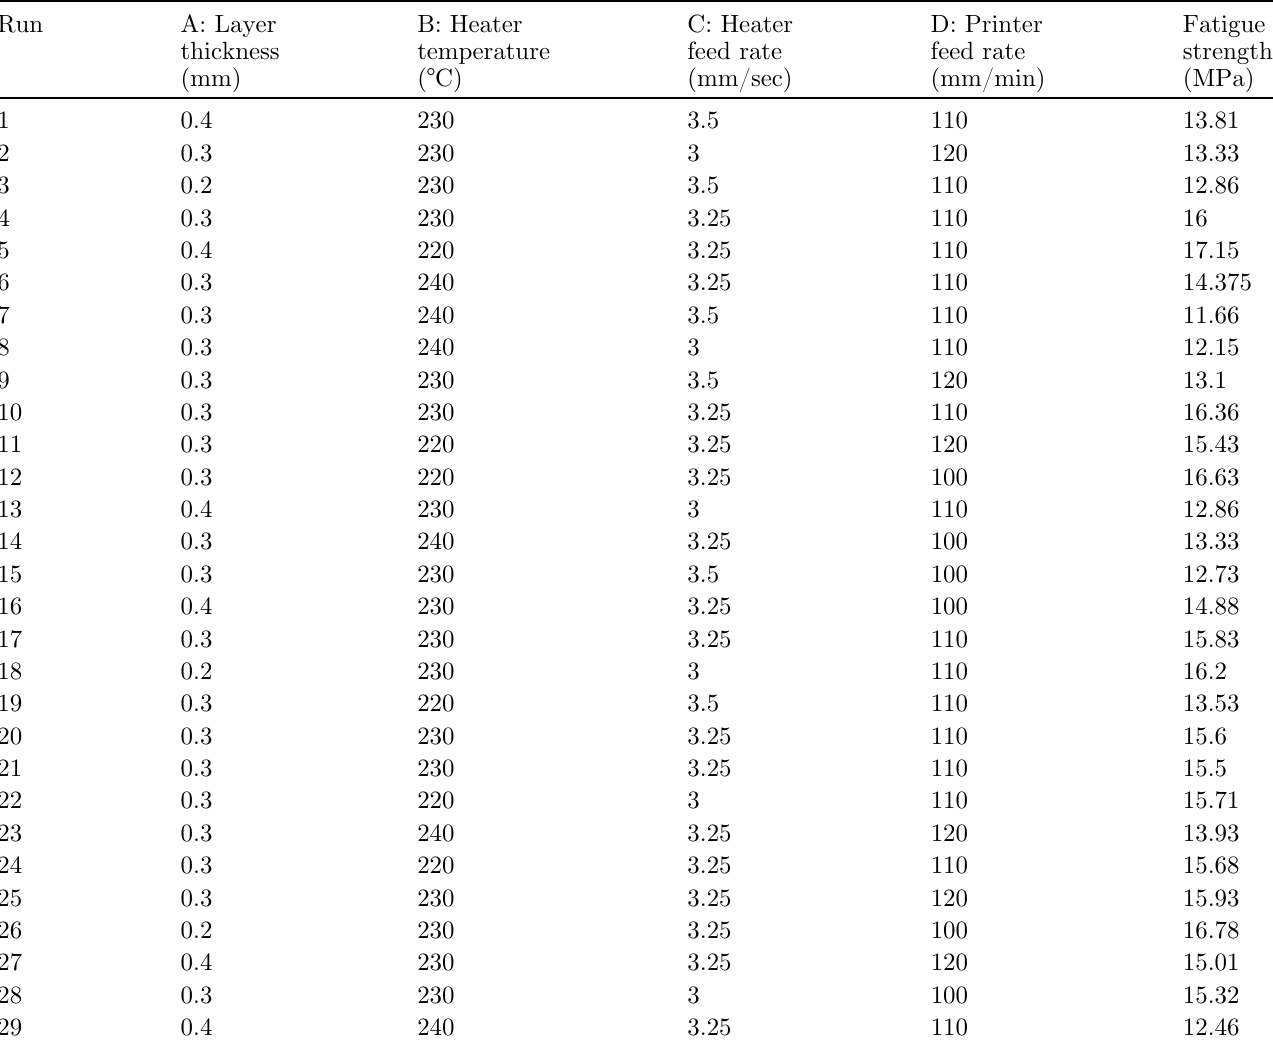
Table 3. Experimental runs and the corresponding experimental fatigue strength